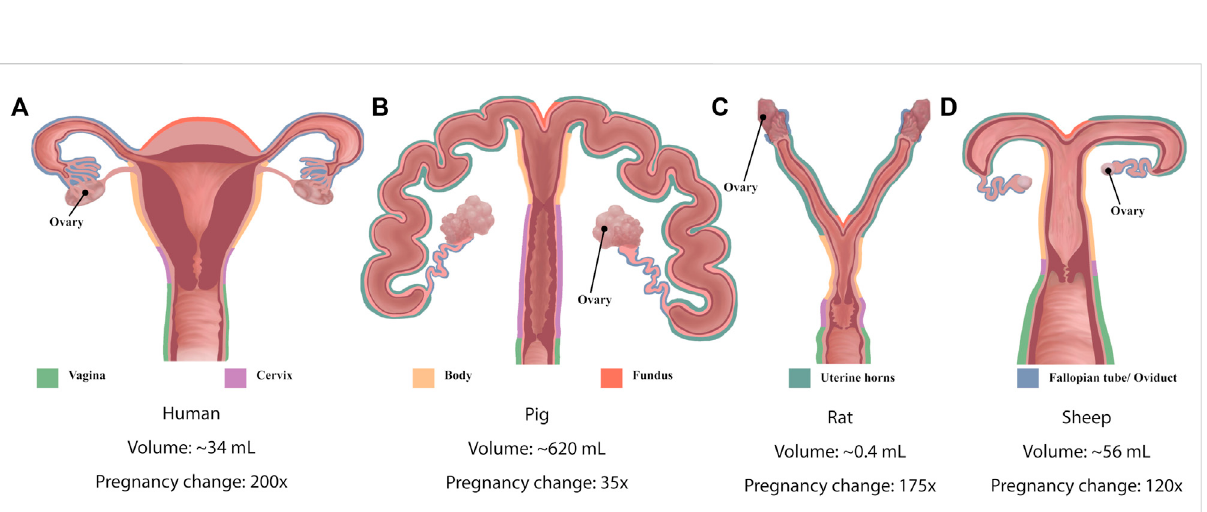
FIGURE 2 Schematic diagrams of the anatomy of (A) human uterus (B) pig, (C) rat and (D) sheep. Colored outlines denote different structures of the uteri. Diagrams shown not to scale. Indicative (approximate) uterine volumes provided, and the fold-change during